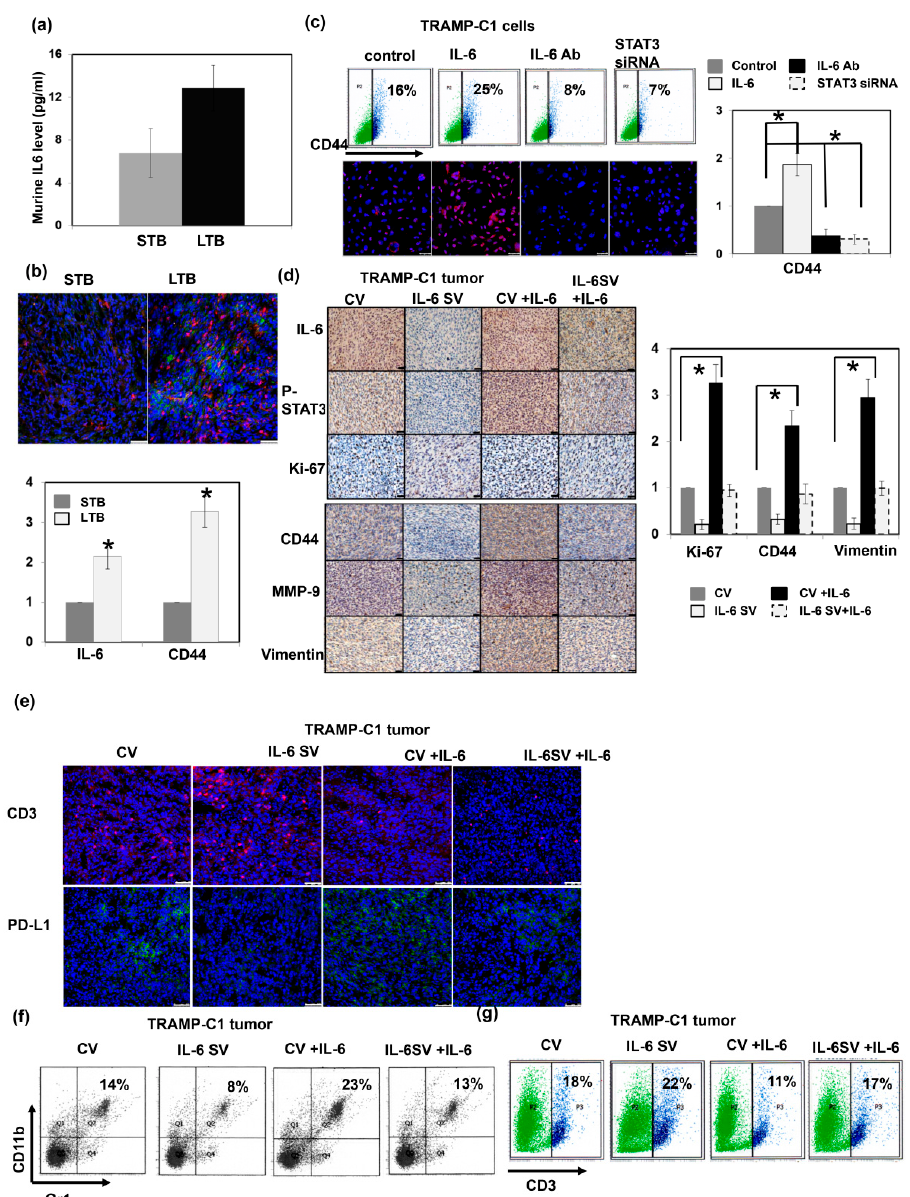
Figure 5. Role of IL-6 signaling in the expression of CD44. ( a ) IL-6 levels measured using ELISA in murine serum from STB and LTB tumors. *, p < 0.05 ( b ) The levels of IL-6 and CD44 were evaluated by IF for cancer cells of LTB compared to those of STB (DAPI, blue; IL-6, green; CD44, red). Scale bars: 50 µm. The quantification is to calculate the value of the cell number positive for targeted protein divided by the total cell number. The Y -axis represents the ratio normalized by the value of STB. *, p < 0.05. ( c ) The levels of CD44 were evaluated by FACS and IF (DAPI, blue; CD44, red) for TRAMP-C1 cancer cells with regulating IL-6 signaling in vitro (IL-6, cells stimulated with IL-6; IL-6 Ab, cells treated with IL-6 neutralization antibody; STAT3 siRNA, cells transfected with STAT3 siRNA). Scale bars: 50 µm. ( d ) The levels of CD44 and EMT changes were evaluated by IHC for TRAMP-C1 cancer cells with regulating IL-6 signaling in vivo (CV, cells transfected with control vector; IL-6 SV, cells transfected with IL-6 silencing vector; IL-6, mice stimulated with IL-6). Scale bars: 20 µm. The Y -axis represents the relative ratio, normalized to the value of CV tumors. *, p < 0.05. ( e ) The levels of PD-L1 and tumor-infiltrating CD3+ cells were evaluated by IF in vivo. Scale bars: 20 µm ( f ) The levels of MDSC (CD11b+Gr1+) recruitment in tumor and ( g ) The levels of tumor-infiltrating CD3+ cells in tumor and were evaluated by FACS.